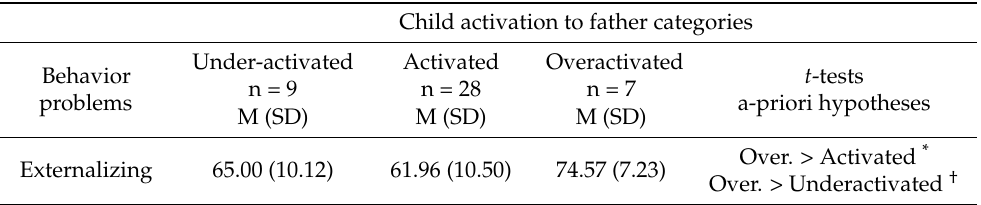
Table 3. Child externalizing behavior (T-score) as a function of child activation to father categories.